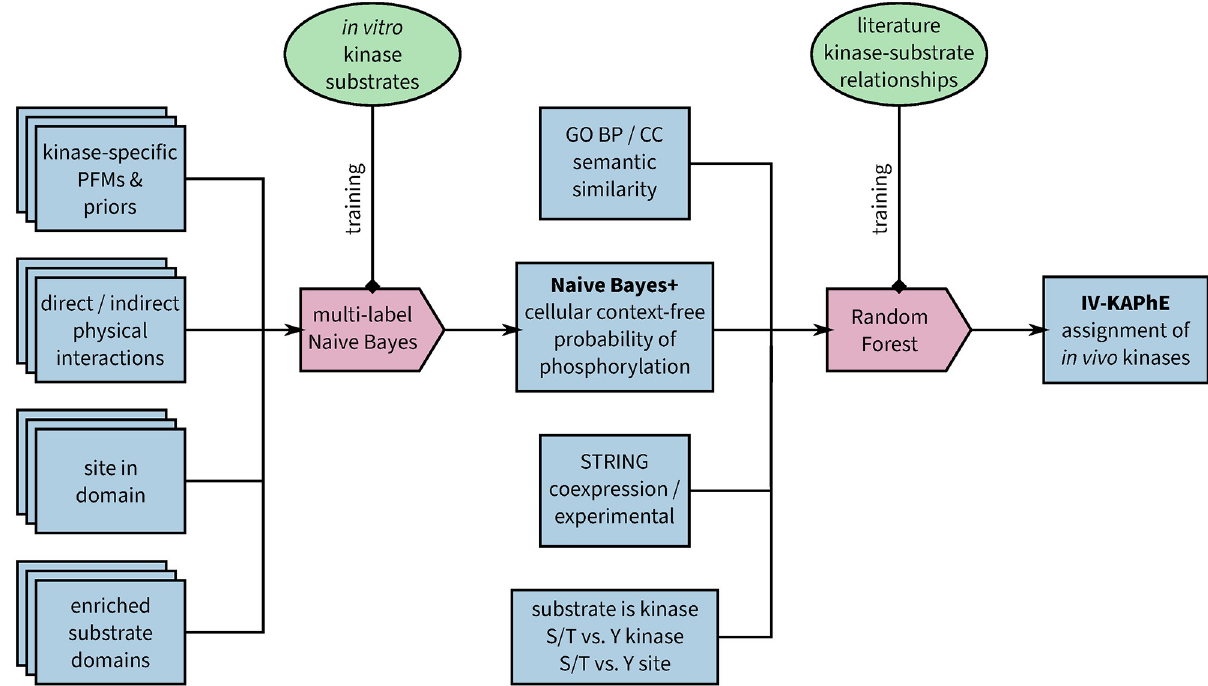
Fig 1. IV-KAPhE is a multi-label kinase-phosphosite assignment method that nests a multi-label model of in vitro assignment in a model of in vivo functional association. Na ï ve Bayes+ consists of sub-models for each kinase, trained from kinase-specific, high-throughput in vitro kinase- substrate relationships. These sub-models together comprise a final, multi-label Na ï ve Bayes model. IV-KAPhE is a monolithic, multi-kinase Random Forest model trained from all literature-derived kinase-substrate annotations and random pairs as negative cases.